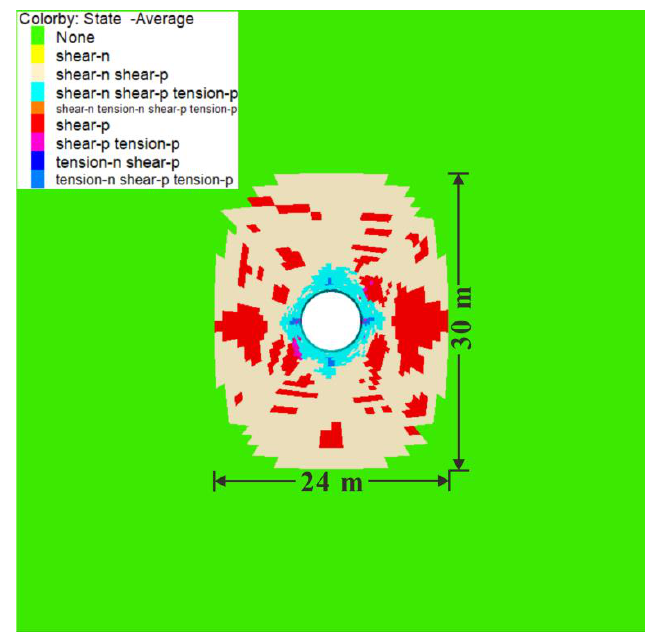
Figure 18. The surrounding rock mass’s displacement without the support scheme: ( a ) Horizontal displacement., ( b ) Vertical displacement.